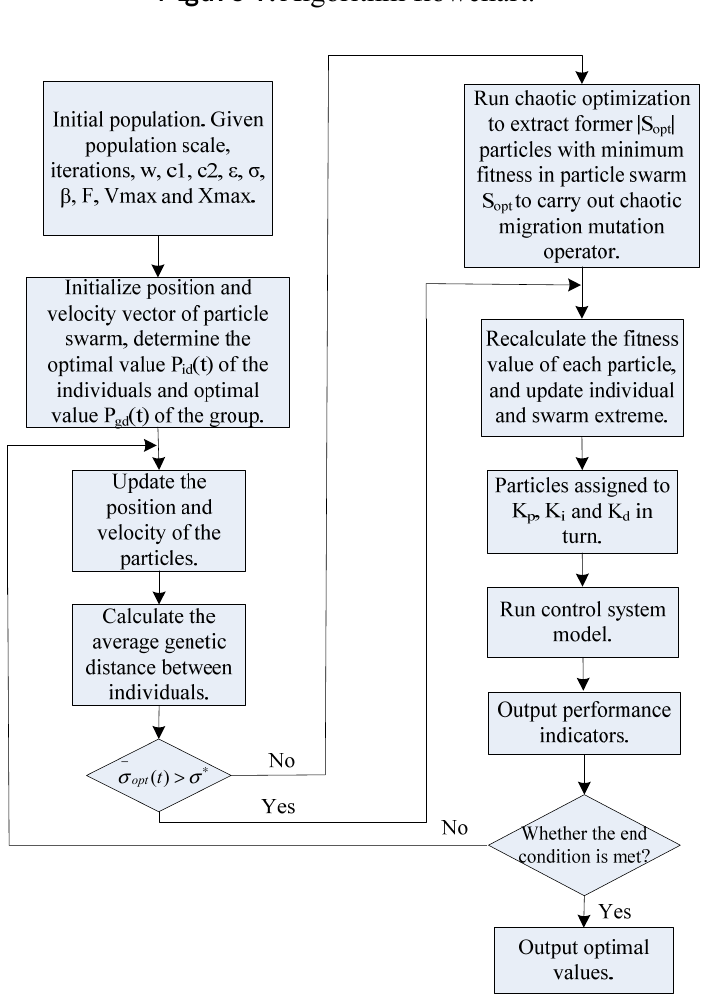
Figure 4. Algorithm